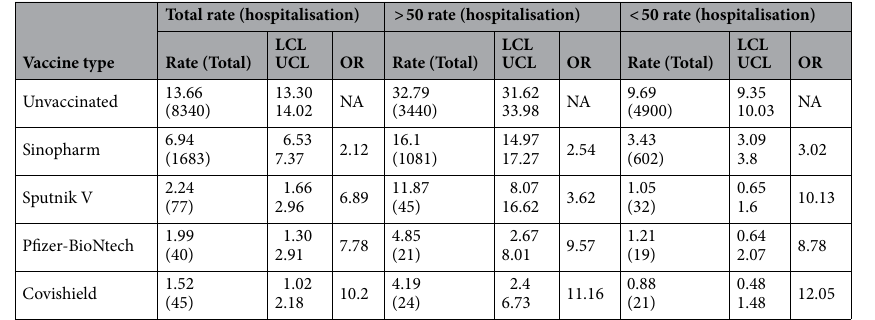
Table 2. Hospitalisation (%) of SARS-COV-2 PCR positive cases (18 + Ages) after Jan 30th. *In pairwise comparison to unvaccinated, all p values < 0.001.